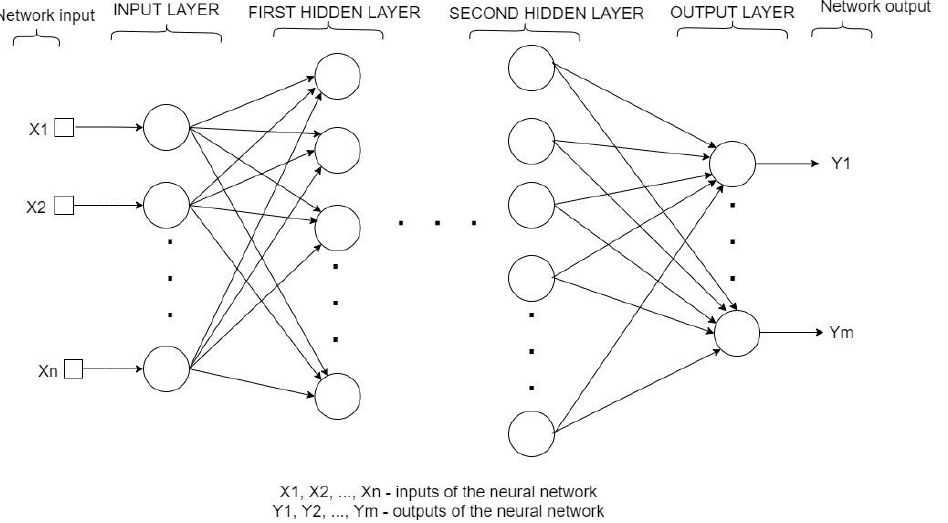
Figure 1. The architecture of a generic multilayer neural network with two hidden layers. Feedback neural networks (bidirectional or recurrent) are artificial NNs in which the connections from the neurons are cyclical, allowing the signal to be conveyed in both directions. This type of network uses a previous output as an additional input to calculate the next output. In other words, the units of such networks have an internal state. Recurrent networks (see Figure 2) are generally operated to classify data that form se- quences, such as in text and images processing. Each element of the word/characters/images sequence can depend on the framework created by the previous elements of the sequence, but these networks are used also to predict some values from temporal data series (data processed at successive time points) [13,19].